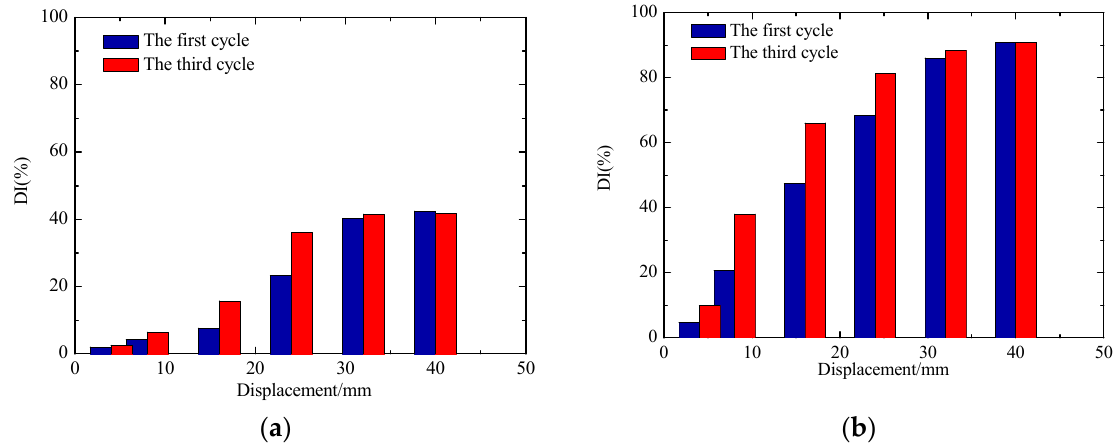
Figure 17. The damage indices of JD-1 in different cycles. ( a ) S1-S2; ( b ) S1-S3.